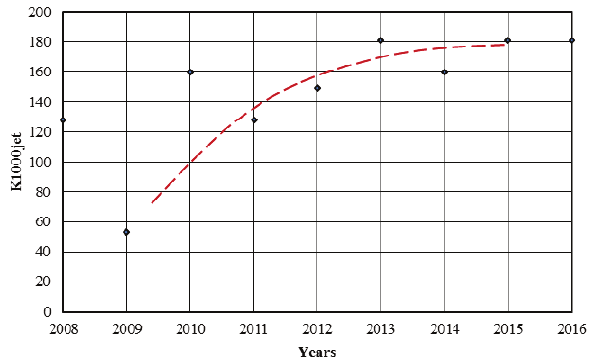
Fig. 25. Changes of the coefficient K 1000jet and the trend line